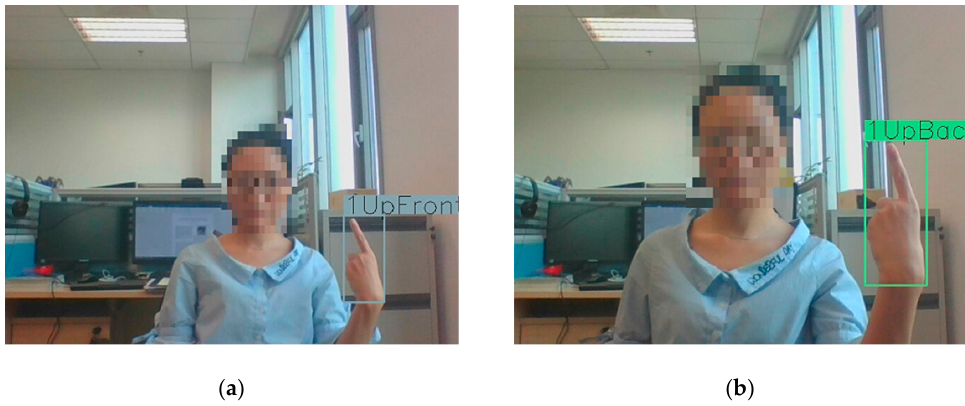
Figure 14. Result of recognition of hand postures in the corridor. Table 10. Confusion matrix for twenty-five hand postures using our dataset.